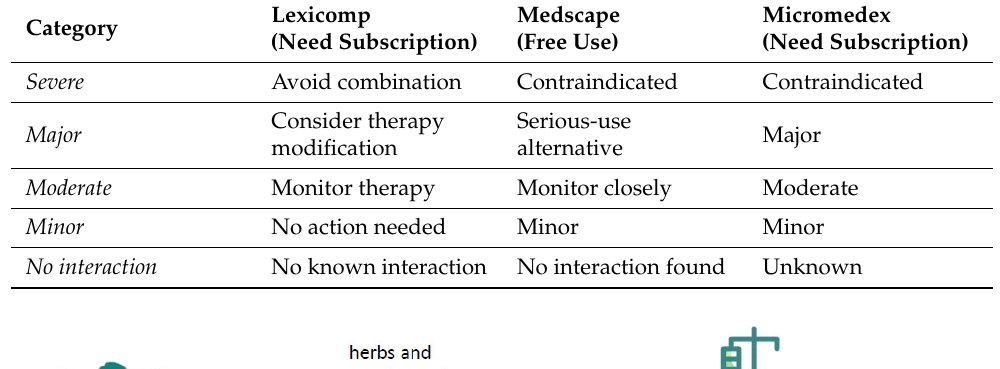
Table 5. Categorization of DDI severity.